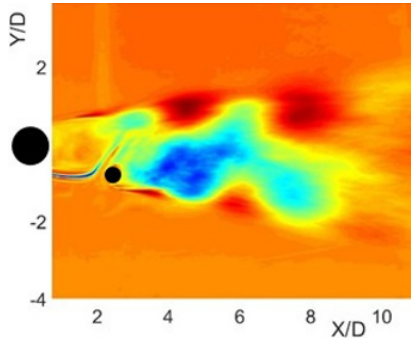
Fig. 6. The third POD mode of position 3